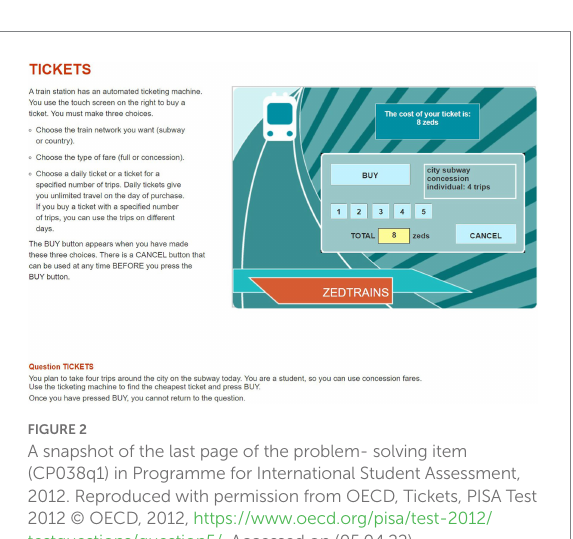
FIGURE 2 A snapshot of the last page of the problem- solving item (CP038q1) in Programme for International Student Assessment, 2012. Reproduced with permission from OECD, Tickets, PISA Test 2012 © OECD, 2012, https://www.oecd.org/pisa/test-2012/ testquestions/question5/, Accessed on